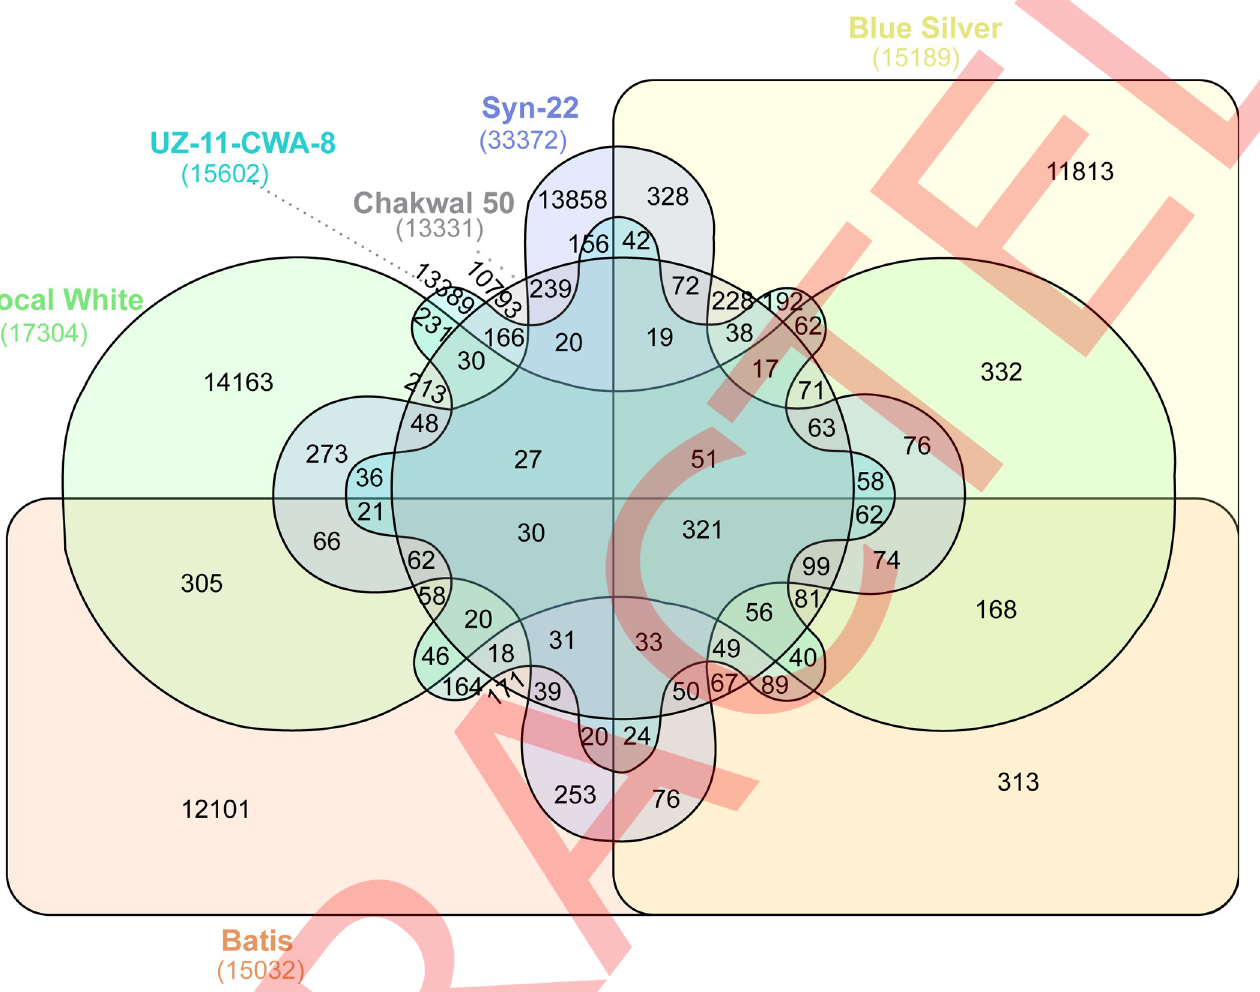
Fig 1. Abundance of RNA editing events by Venn diagram analysis among six genotypes of wheat. The genotypes (Blue Silver = light yellow; Syn-22 = light blue; Chakwal 50 = light grey; UZ-11-CWA-8 = light cyan; Local White = light green; and Batis = light orange) were shown with different colors.